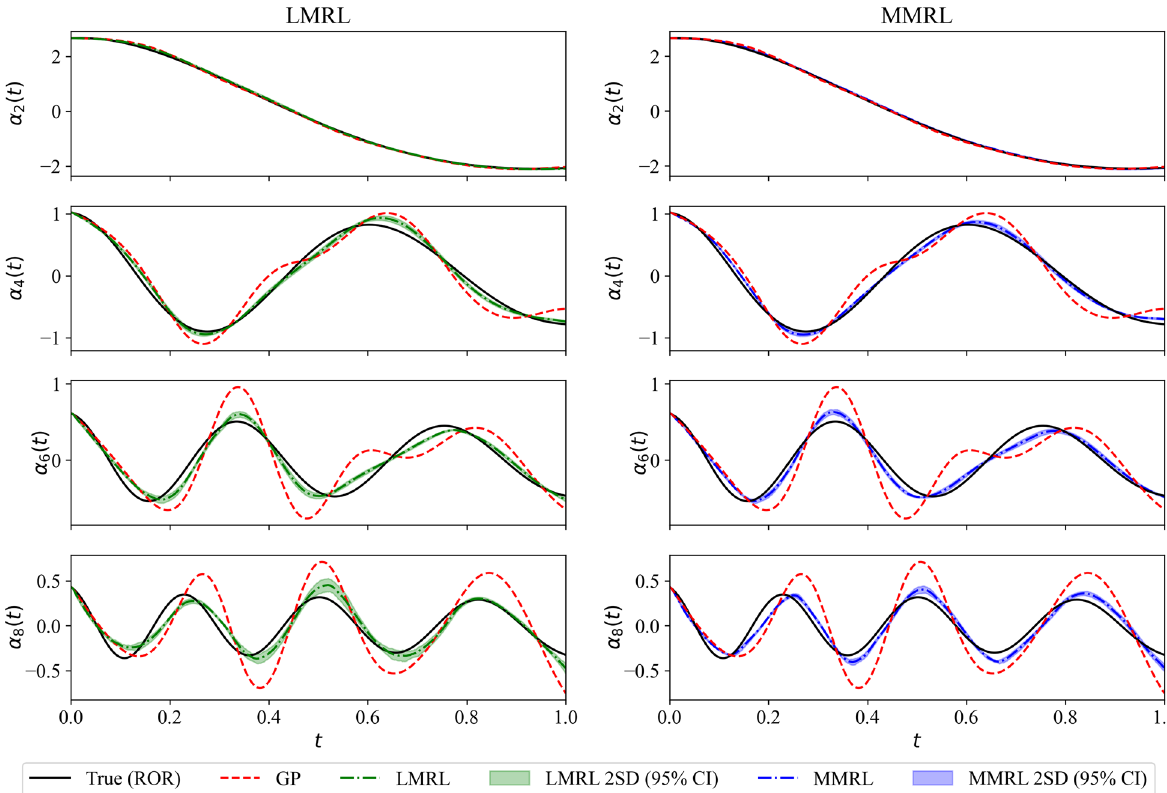
Figure 6. Evolution of the second, fourth, sixth and the last POD modal coefficients at Re = 1500 for LMRL (left) and MMRL (right) approaches.